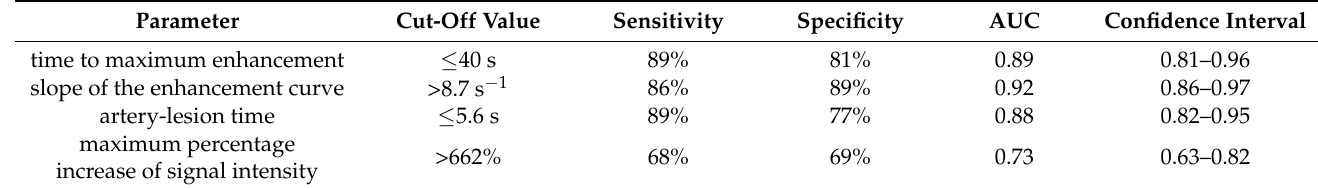
Table 2. Values of optimal cut-off values, sensitivity, specificity and AUCs for high-slope vascular malformations (HFVMs) for time to maximum enhancement, slope of the enhancement curve, artery- lesion time, maximum percentage increase of signal intensity of the lesion. The differences between AUCs were statistically significant ( p <